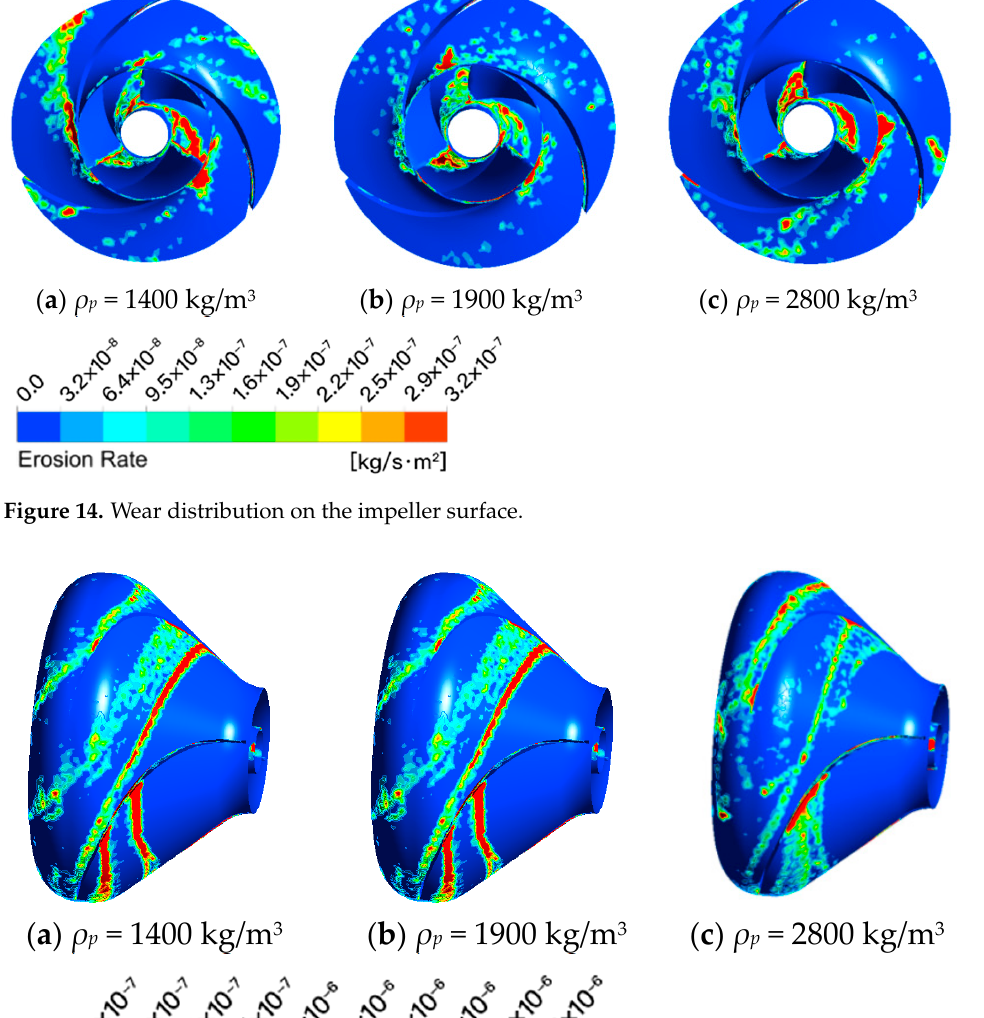
Figure 15. Wear distribution on surface of the guide vanes.